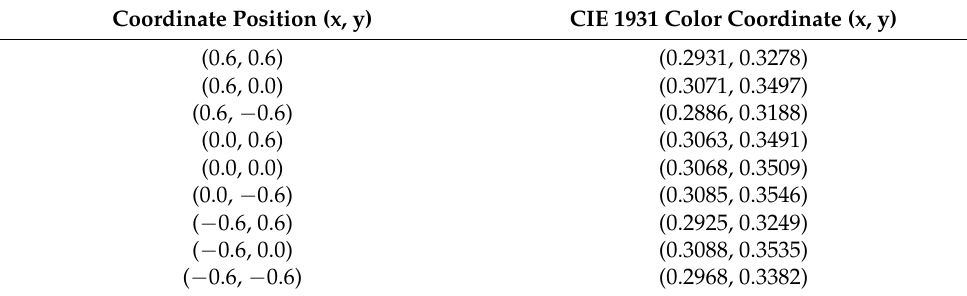
Table 1. CIE 1931 color coordinates of the nine points.